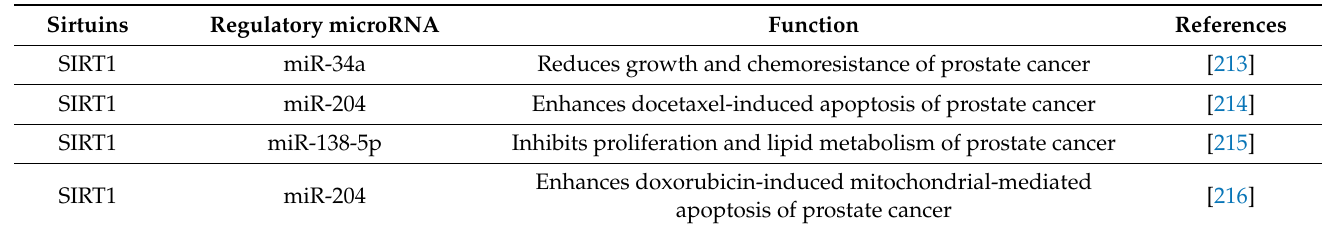
Table 4. Mechanistic Roles of Sirtuins (SIRT1–7) Regulation by miRNAs in Prostate